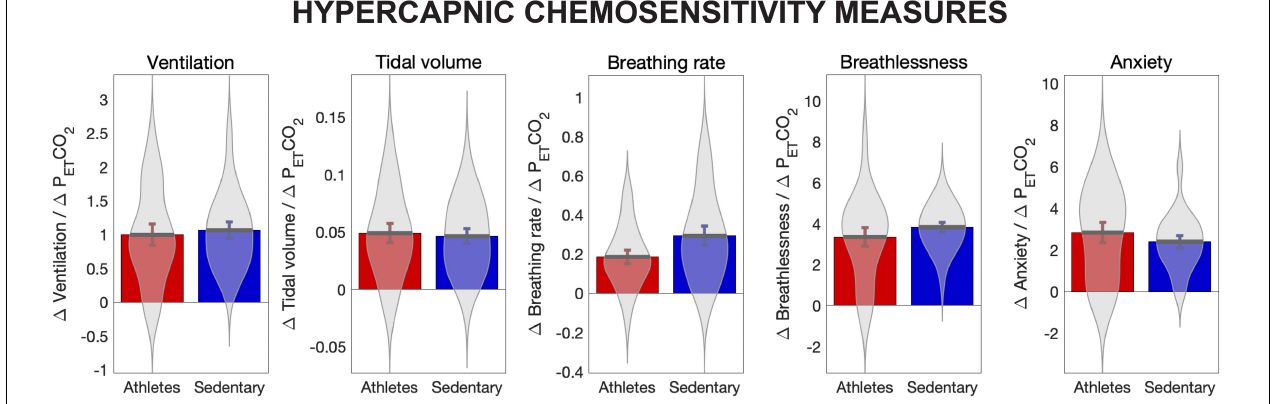
FIGURE 1 | Hypercapnic chemosensitivity measures for athletes and sedentary controls. Hypercapnic chemosensitivity for ventilation, tidal volume, breathing rate, perception of breathlessness and perception of breathing-related anxiety are the rate of change in each value for each mm Hg increase in P ET CO 2 , calculated using the slope parameter from a fitted linear model. Ventilation, tidal volume and breathing rate were normalised to height. No significant differences were observed between groups for any chemosensitivity